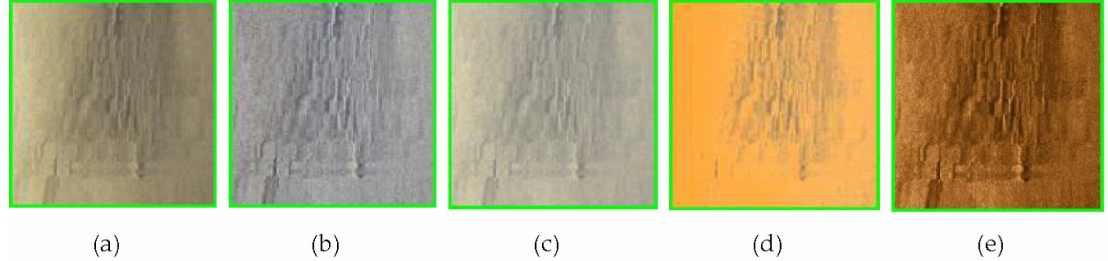
Figure 10. Comparison of experimental details. Images enhanced with ( a ) SSR, ( b ) MSR, ( c ) MSRCR, ( d ) MSRCP, and ( e ) using our bilateral filtering